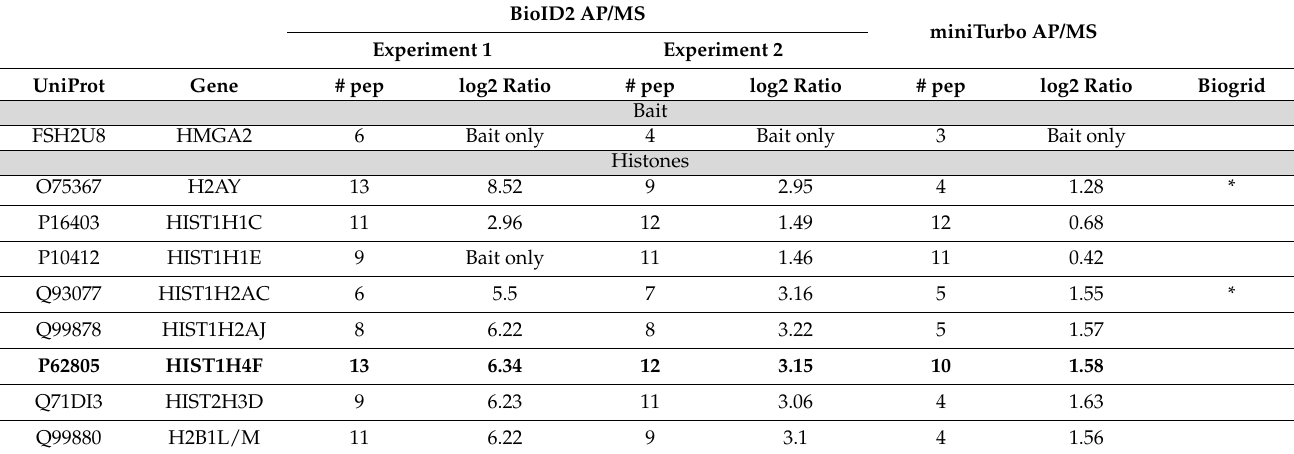
Table 1. Top HMGA2 interacting candidates identified in both SILAC BioID2 and miniTurbo AP/MS experiments. For each experiment, the # of peptides identified is noted, along with the log2 SILAC ratio quantified by MaxQuant or calculated based on intensity values (italicized). “Bait only” indicates that the protein was only biotinylated/captured from cells expressing ligase-tagged HMGA2. Proteins annotated on Biogrid as putative HMGA2 interactors are indicated. Comparison to the Gingras lab’s BioID control dataset [47] is annotated as follows: (-) not detected, ( ≤ ) fewer or same number of peptides detected in NLS-BirA* datasets compared to GFP-BirA* datasets, (# peptides detected in NLS-BirA* datasets/# peptides detected in GFP-BirA* datasets). Proteins in bold text were further validated by co-precipitation or BioID/Western blot analysis (see Figure